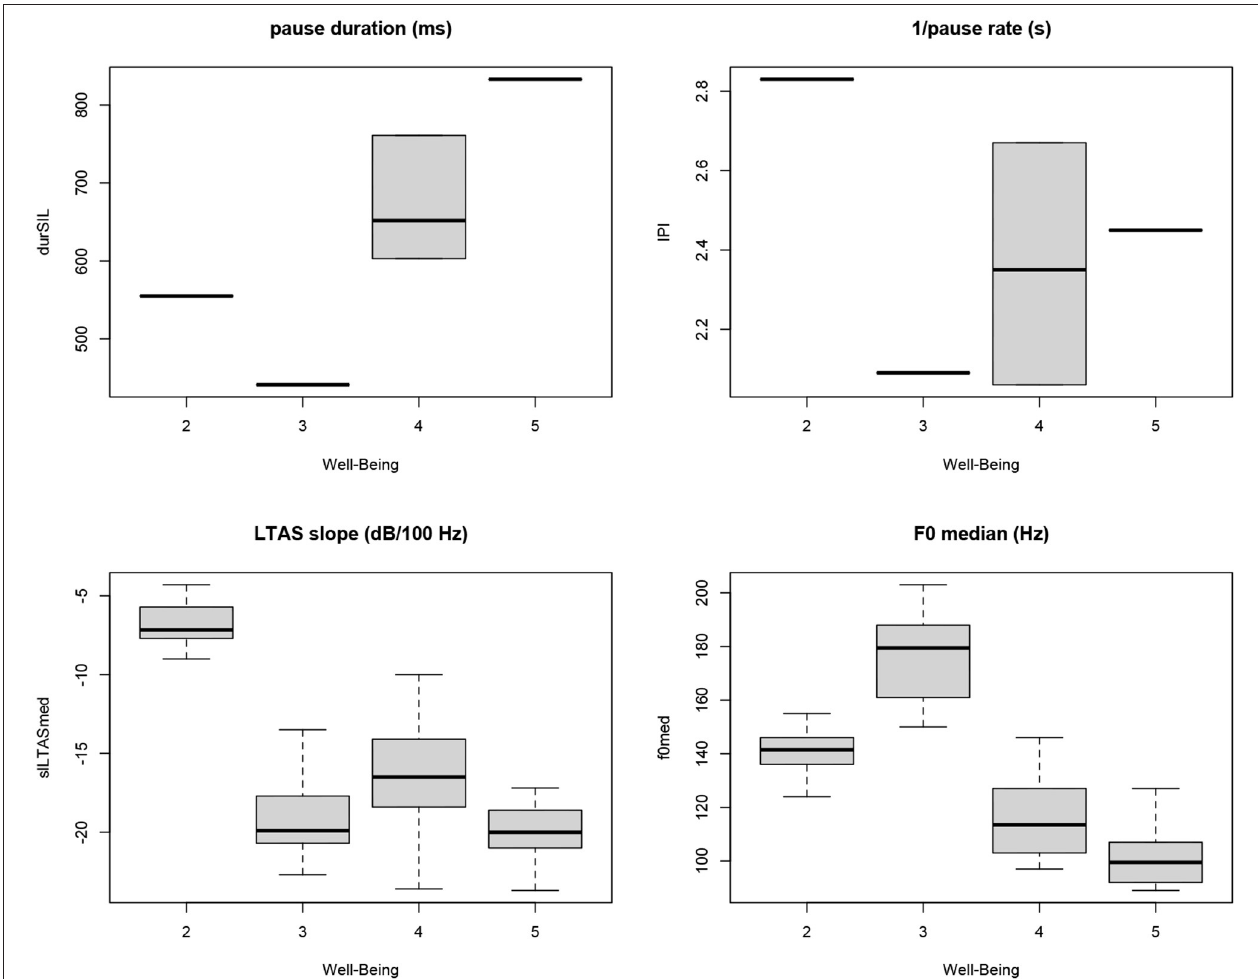
FIGURE 4 | Boxplots of the four acoustic parameters that predict for the BP dataset. Results for male reciters